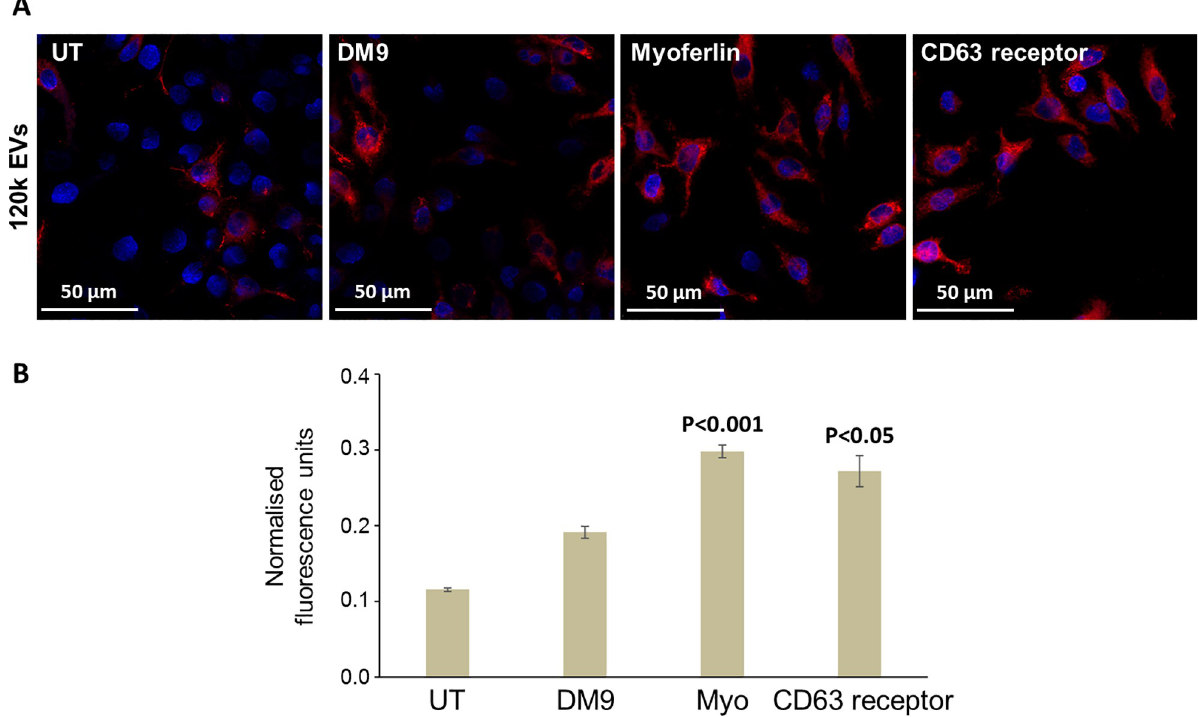
Fig 9. Antibodies raised against specific F . hepatica EV surface proteins also influence uptake by macrophages. (A) RAW264.7 macrophages were incubated with PKH26-labelled 120k EVs for 3 h at 37˚C and the cells were analysed by confocal microscopy. Pre-treatment of labelled EVs with antibodies raised against specific F . hepatica proteins (DM9, myoferlin and CD63 receptor) resulted in a greater level of internalisation by macrophages compared to control EVs (left panels). (B) Internalisation of myoferlin- and CD63 receptor-treated EVs was statistically significant when measured as fluorescence intensity relative to cells incubated with untreated